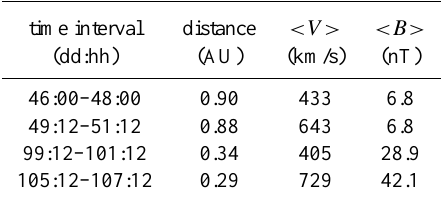
Table 1. Time extremes and average values characterizing the in-